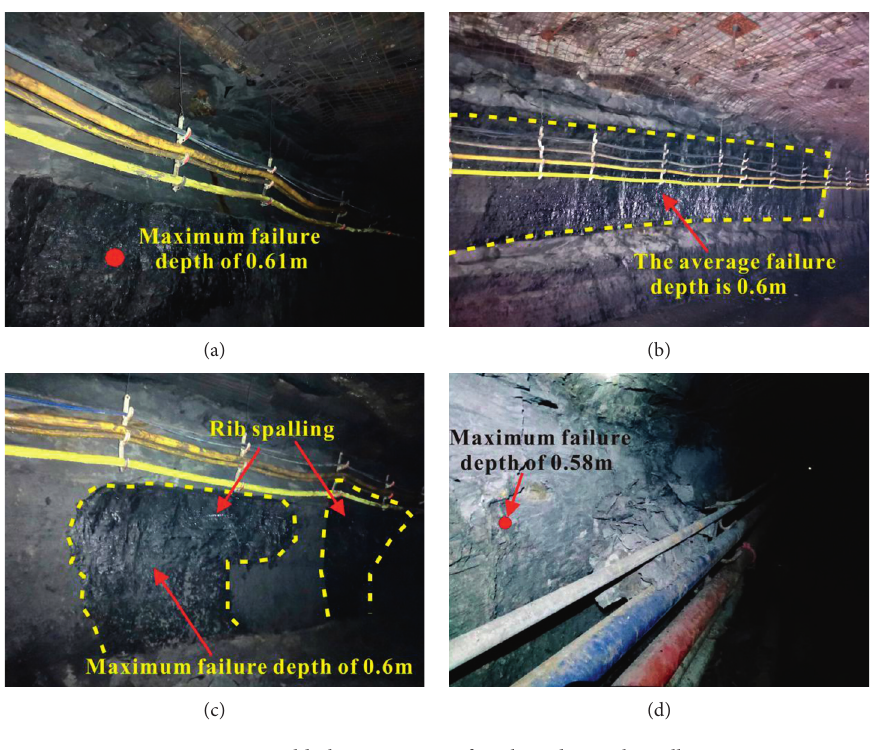
Figure 15: Field characteristics of coal roadway rib spalling.